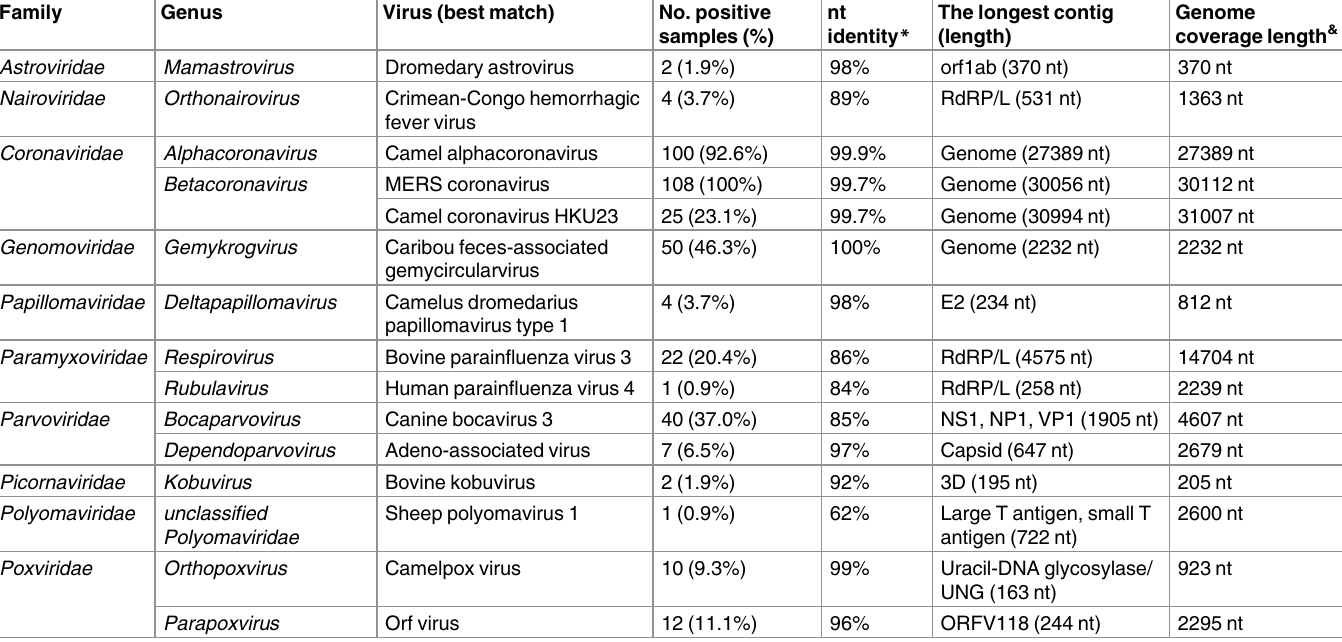
Table 1. Mammalian viruses detected in camels from a single live animal marketin the United Arab Emirates.